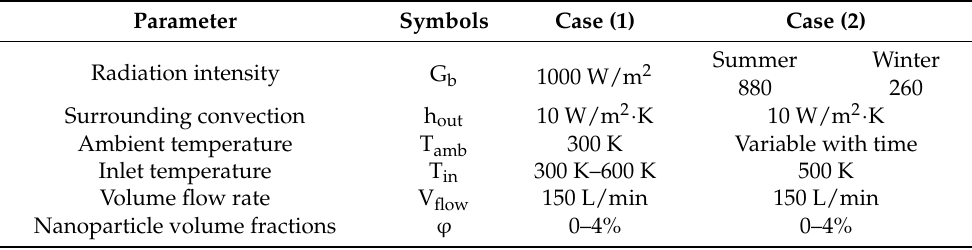
Table 3. Constant and variable operating